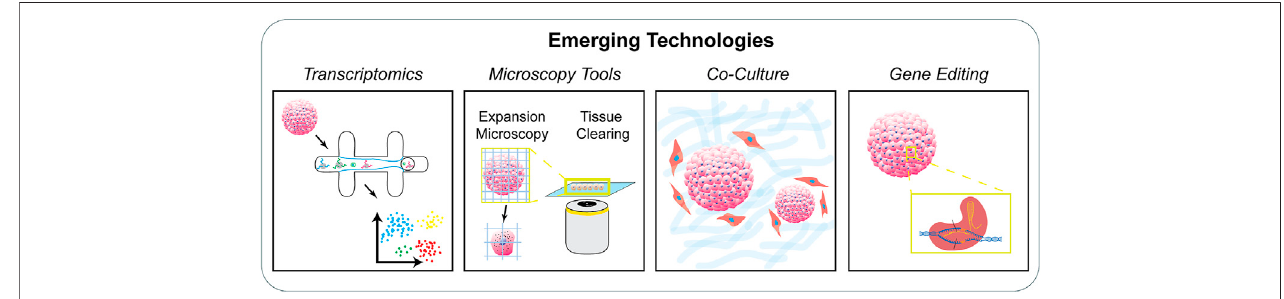
FIGURE4| Emergingtechnologiestostudythestemcellniche.Thereisanincreasingneedtocharacterizestemcellpopulationsorganizedinengineeredsystems. Techniquesincluding singlecelltranscriptomics,advancedmicroscopytechniques,co-culture systems,andgeneeditingtoolsprovidenewavenuestostudystemcells in controlled